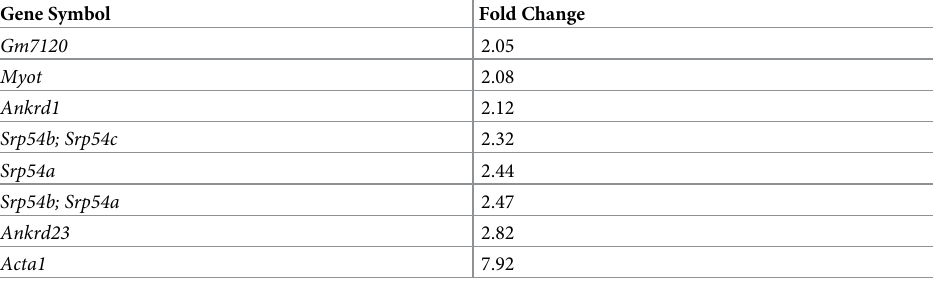
Table 4. Significant 8 mRNAs detected with microarray analysis, all of which were increased in young